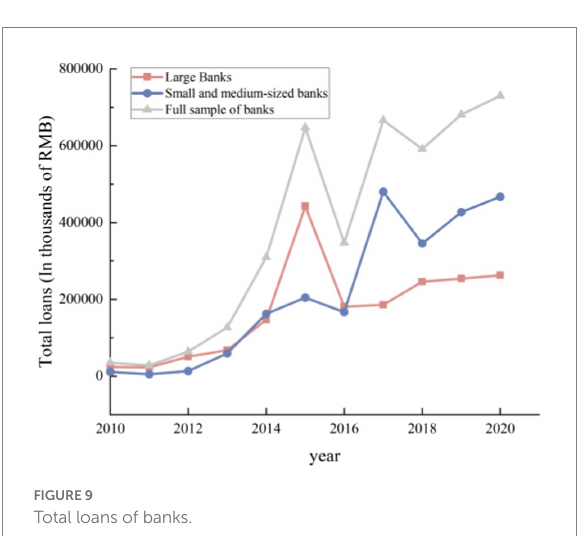
FIGURE 8 Number of companies for the loan.